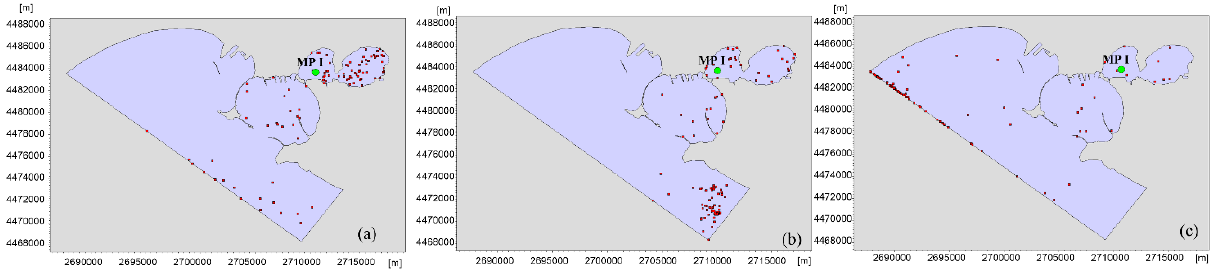
Figure 17. Percentage PT4 (MPI) — the cloud of particles: ( a ) 30 days after release; ( b ) 60 days after release; ( c ) 90 days after release at bottom layer.